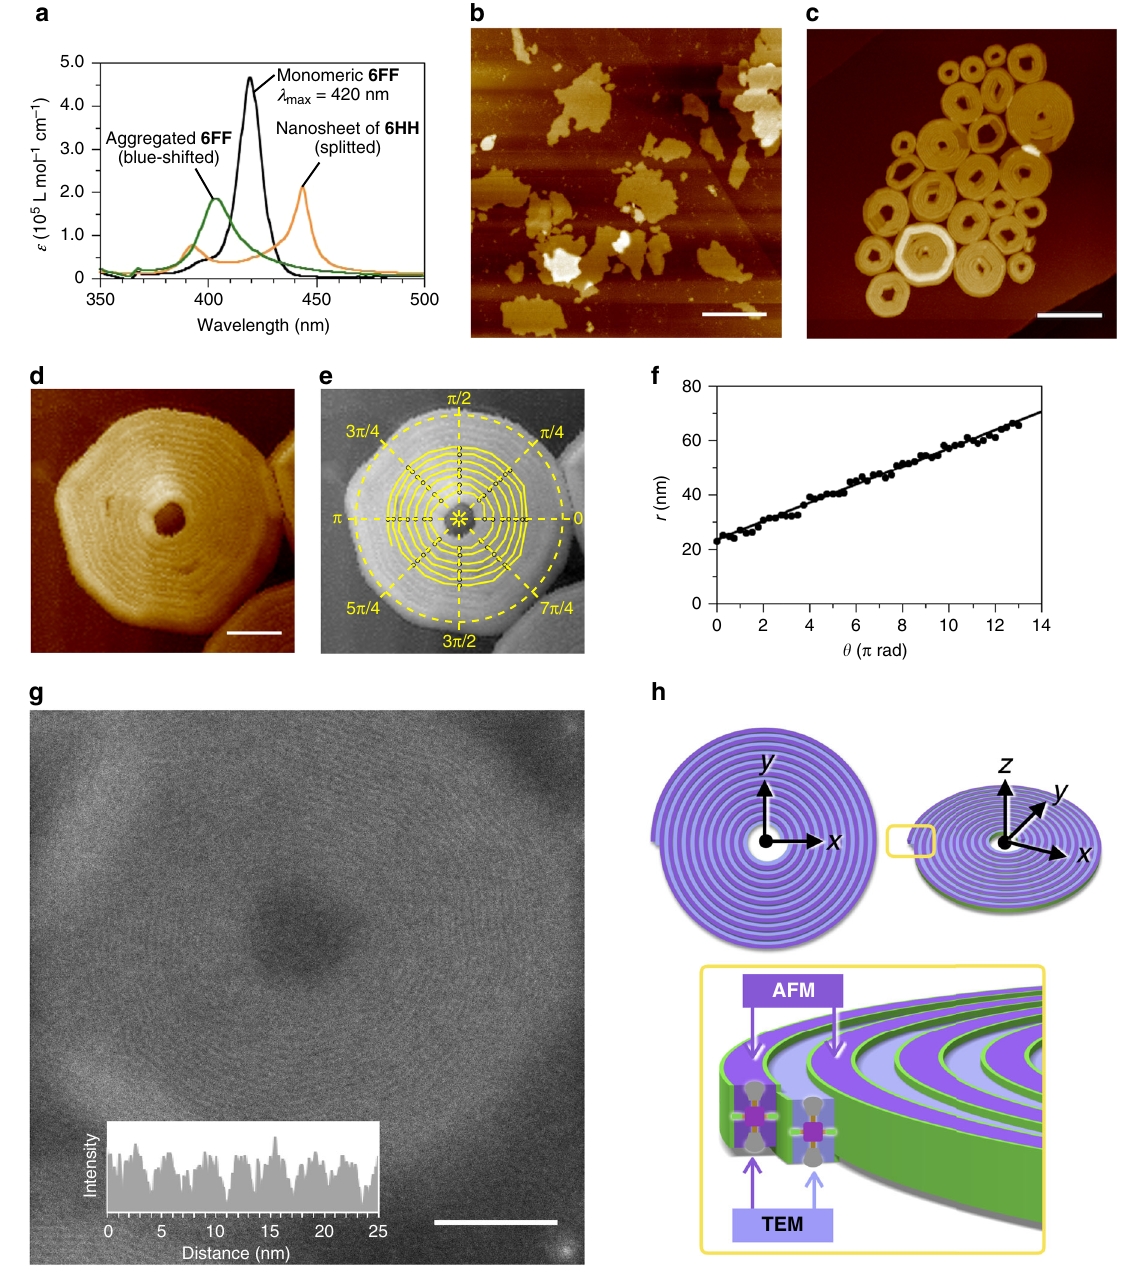
Fig. 2 Self-assembly of 6FF. a Absorption spectra of supramolecular nanosheets of 6HH (50 μ M in methylcyclohexane at 283 K), Archimedean spirals of 6FF (12.5 μ M in dodecane at 298 K), and monomeric 6FF (12.5 μ M in dodecane at 373 K). Spectra of the aggregates were measured under conditions of concentration and temperature where the degree of aggregation is close to unity. b AFM image of supramolecular nanosheets of 6HH . Scale bar = 200 nm. c – e AFM images of Archimedean spirals of 6FF . Scale bar = 200 nm ( c ) and 50 nm ( d ). The images displayed in d and e are inverted so that the spiral is shown as anticlockwise in the polar coordinate. f Plot of r against θ for the points in the polar coordinates shown in e . g ADF – STEM image of the Archimedean spiral of 6FF . Scale bar = 50 nm. Inset: cross-sectional histogram. h Schematic representation of self-assembly of 6FF to form a supramolecular double-stranded Archimedean